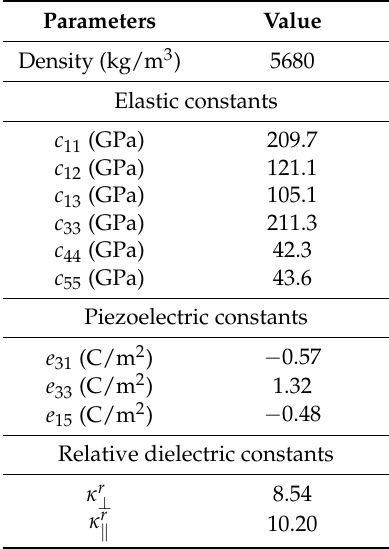
Table 1. List of parameters for modeling.